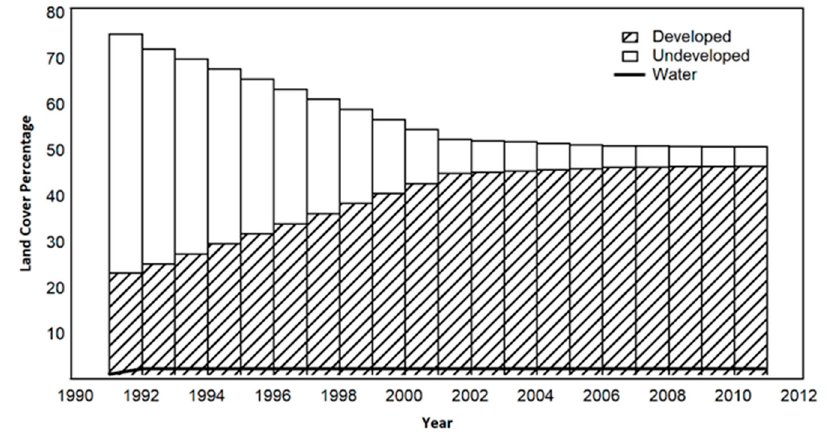
Figure 4. Time series trend of land-cover change within the Cuyahoga